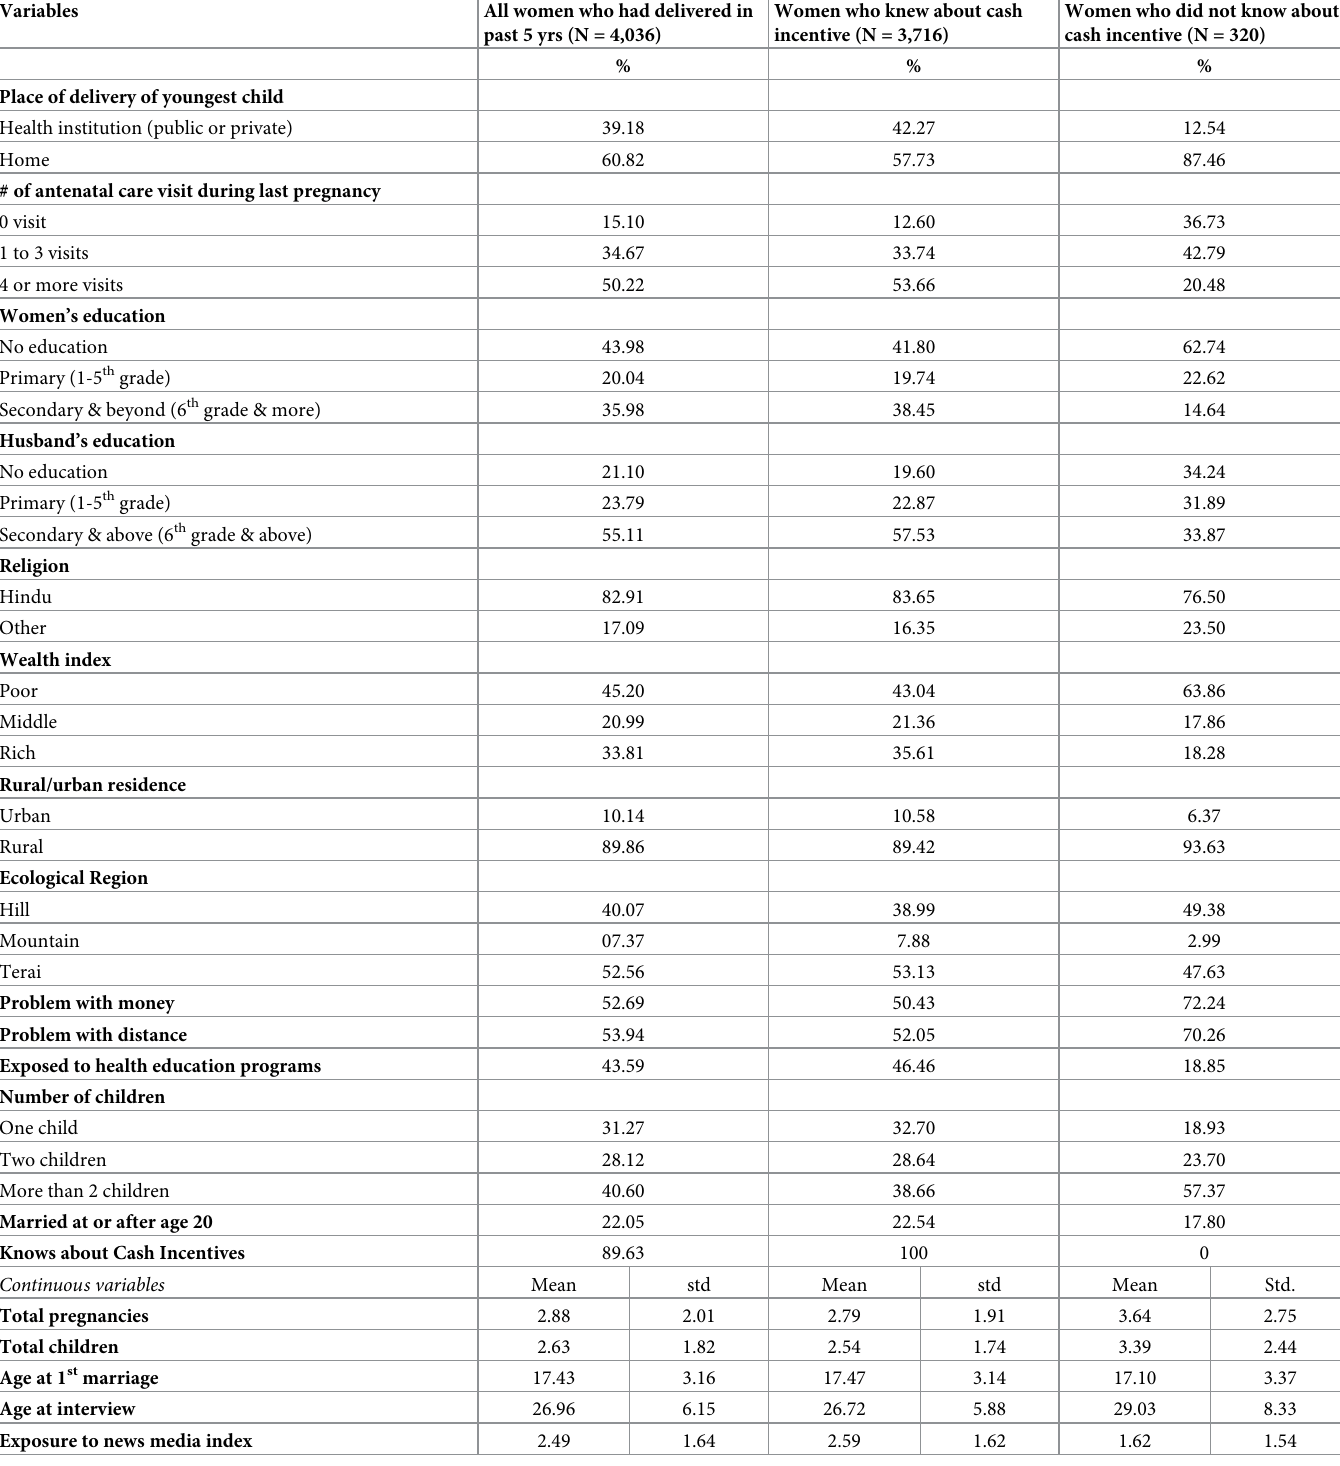
Table 2. Weighted descriptive results using individual data from Nepal,